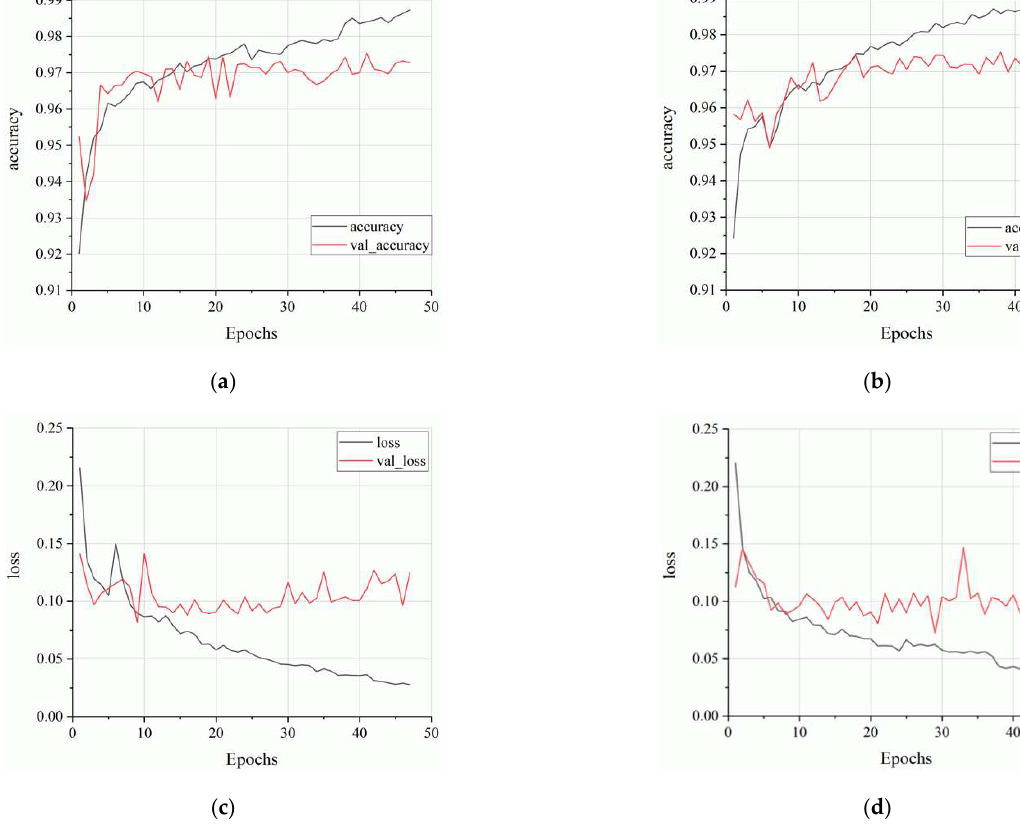
Figure 3. Variation dynamics of training and validation accuracy ( a , b ) and training and validation loss ( c , d ) during the training of model 11 ( a , c ) and model 12 ( b , d ).